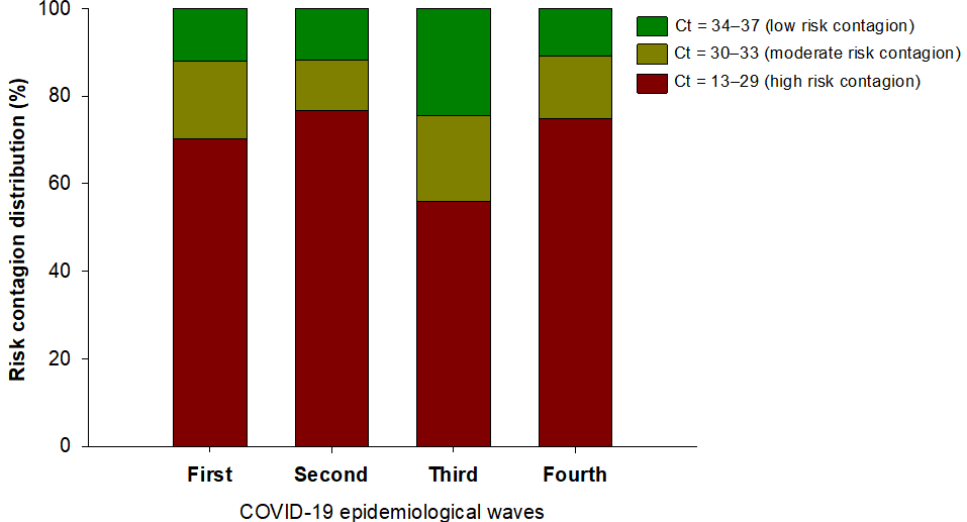
Figure 1. Percentages of people categorized (Ct < 29 high viral load, Ct 30–33 medium viral load,